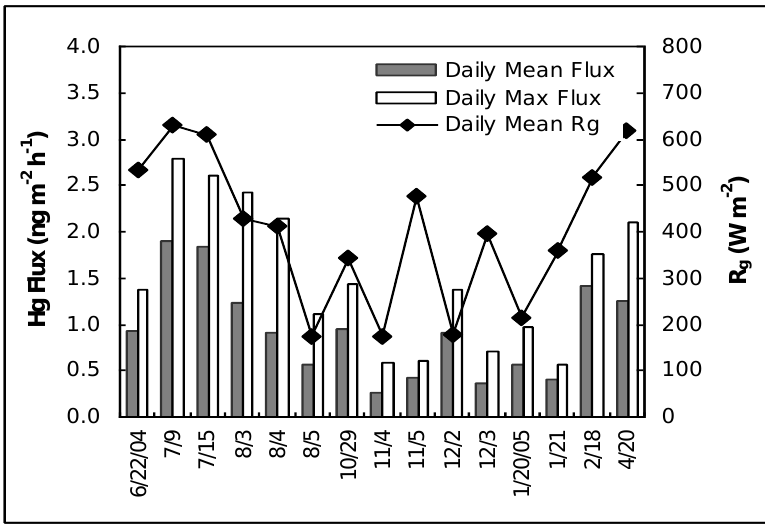
Figure 3. Daily mean and maximum fluxes of the Hg air/water exchange at Cane Creek Lake (TN, USA) and daily mean solar radiation values ( R g ) from June to April. Table 3. Seasonal variation of the Hg air/water exchange fluxes and meteorological parameters obtained at Cane Creek Lake (TN, USA).